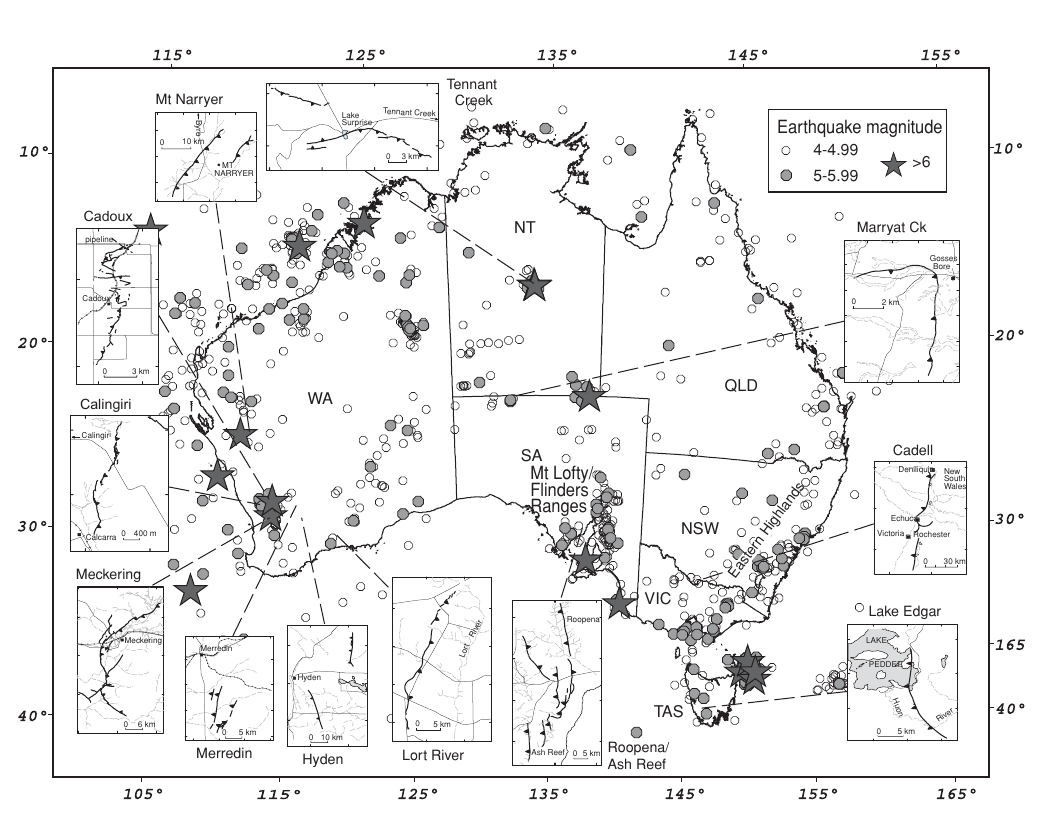
Fig. 1. Seismicity of Australia, 1900-2002, and recent fault scarps (modified after McCue, 2001). Earthquakes relating to the northern margin of the Australian plate have been removed from the image for clarity. for M < 6 and M for M > 6. WA = Western Australia; Earthquake magnitudes are presented as M L S NT = Northern Territory; QLD = Queensland; SA = South Australia; NSW = New South Wales; VIC = Vic- toria; TAS =